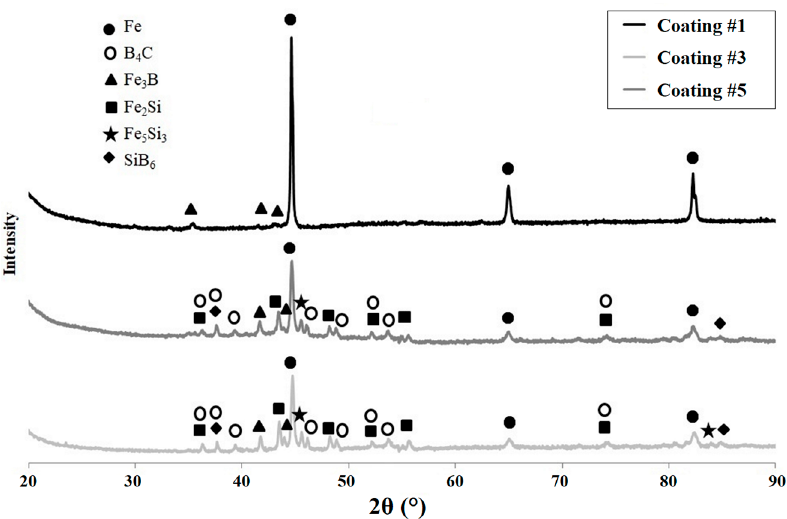
Figure 6. X-ray diffraction of Fe – B and Fe – B – B 4 C – Si composite coatings (specimen numbers in Figure 6. X-ray di ff raction of Fe–B and Fe–B–B 4 C–Si composite coatings (specimen numbers